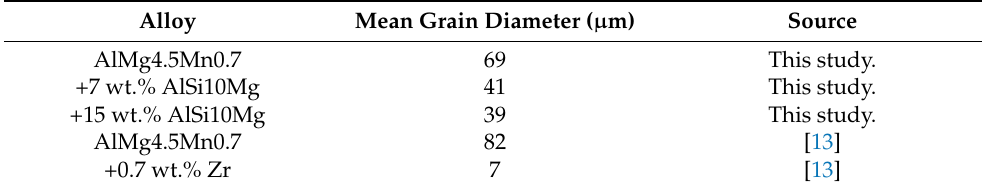
Table 7. Calculated mean grain diameter from the EBSD results for the different alloys.